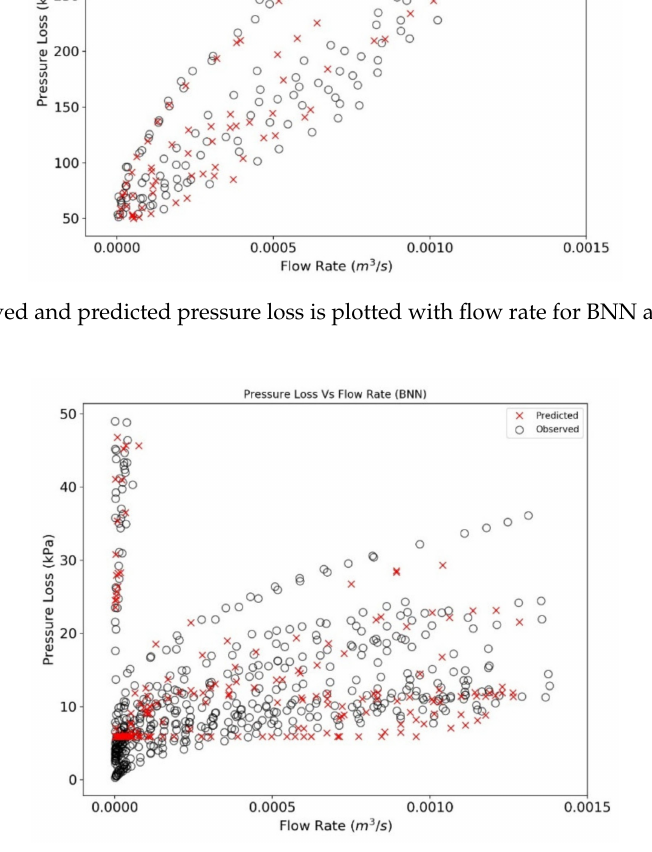
Figure 16. Observed and predicted pressure loss is plotted with flow rate for BNN algorithm for low pressure regime.